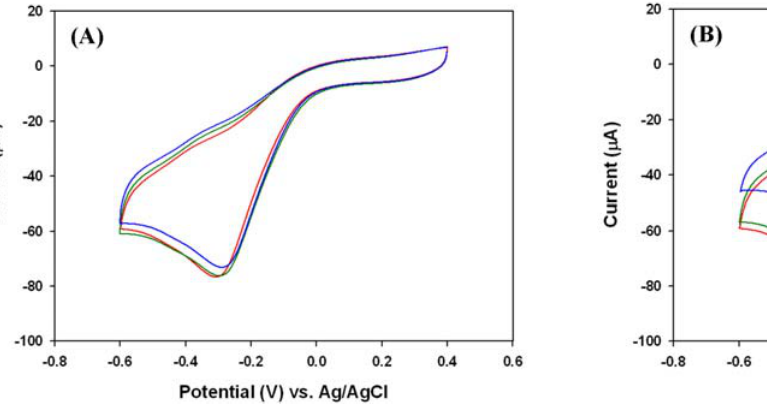
O in 0.1 M phosphate buffer (pH 6.2). In both Figures, 2 2